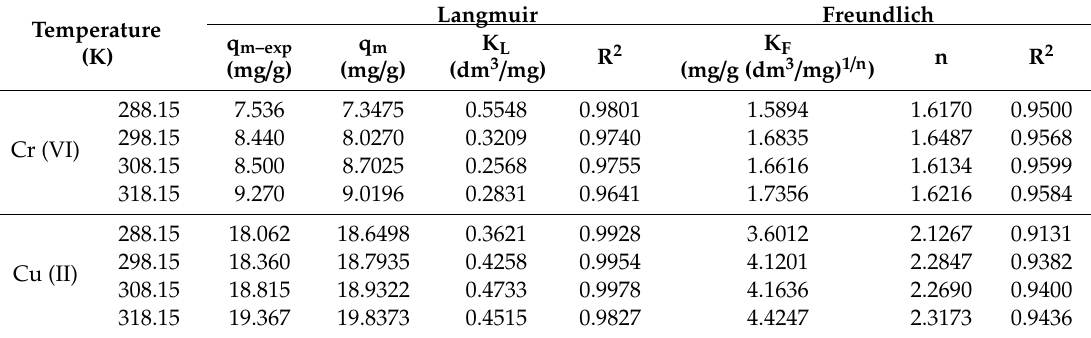
Table 1. Langmuir and Freundlich isotherm model concerning the adsorption of Cr(VI) and Cu(II) by Fe 3 O 4 .